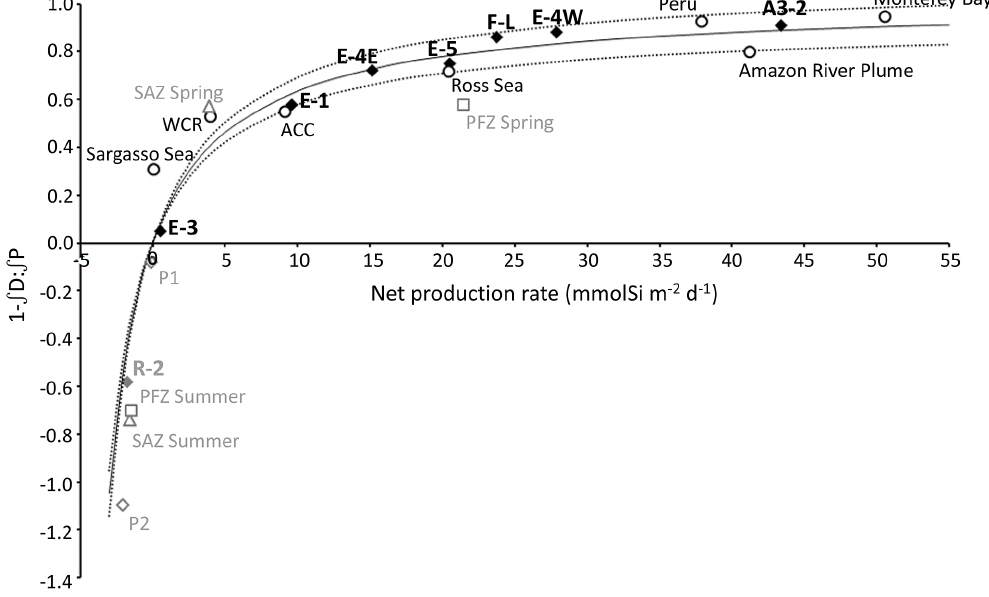
Figure 6. Fraction of biogenic silica production supported by new silicic acid (1 − R D : R P ) as a function of the integrated net silica production rate ( ∫ ρ net ) during KEOPS-2 (solid black diamonds) compared with different regions of the global ocean (open circles, Brzezinski et al., 2003, and references therein; and open diamonds, Fripiat et al., 2011b). Triangles and squares show the mean values for different growth seasons for SAZ and PFZ, respectively (Fripiat et al., 2011b). The solid line is a rectangular hyperbola made to fit all data points (grey symbols were excluded from the model since they either represent negative 1 − R D : R P values which are not allowed by the model or represent averages while all other symbols refer to single stations). The equation of the curve is 1 − R D : R P = 1.01 × ∫ ρ net / (5.89 +∫ ρ net ). Dotted lines correspond to ± 1SD of the 1 −∫ D : ∫ P max